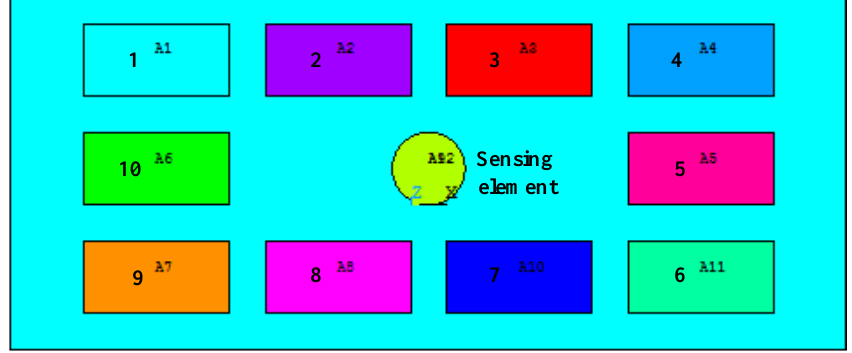
Figure 5. Diagram of simplified PCB thermal model (the digit stands for the position number of the